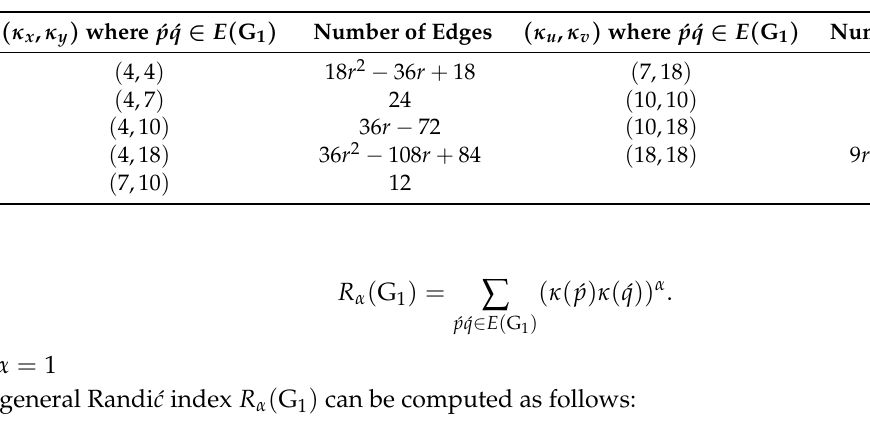
Table 1. Edge partition of hex-derived network of type 3 HDN 3 ( r ) based on degrees of end vertices of each